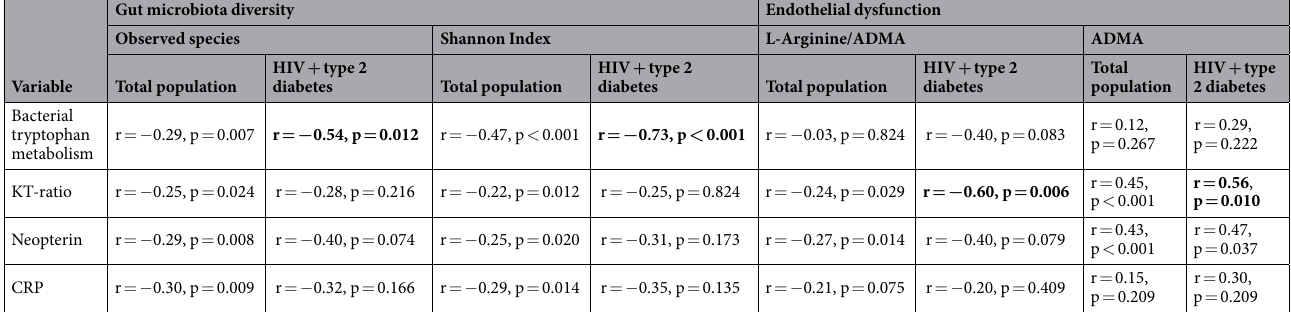
Table 3. Correlations between alpha diversity measures, endothelial dysfunction and bacterial genes related to tryptophan metabolism, KT-ratio and inflammation in the total study population (n = 84) and the HIV-infected individuals with type 2 diabetes (n = 21). Data as Pearson correlations. Pearson correlations > 0.5 in bold. ADMA: Asymmetric dimethylarginine, CRP: C-reactive protein, KT: Kynurenin/Tryptophan. CRP-levels were log-transformed before correlation